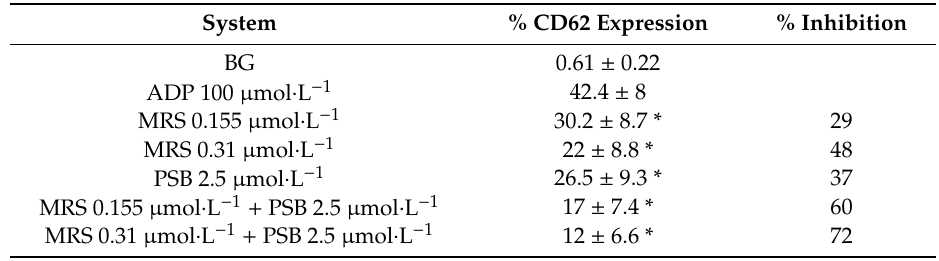
Table 1. E ff ect of MRS2500 (0.155 and 0.31 µ mol · L − 1 ) and PSB0739 (2.5 µ mol · L − 1 ) individually and in combination on CD62P expression by ADP-activated platelets, as well as the magnitude of inhibition.